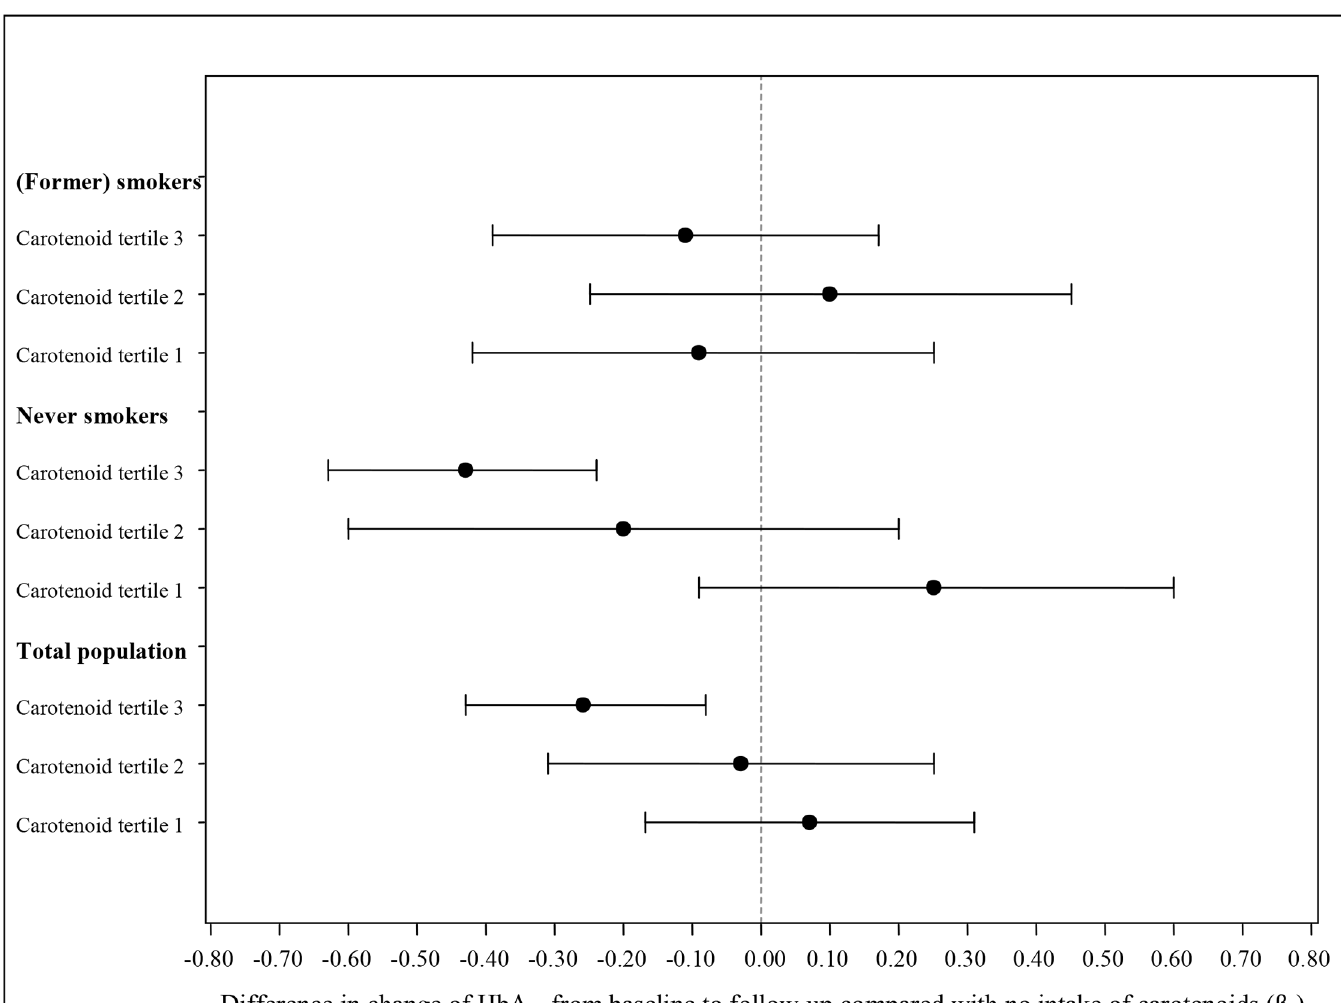
Fig 1. Longitudinal association between regular carotenoid intake amount from supplements and medications in tertiles and levels of HbA 1c over 10 years (1994/95 to 2004/05). n Total population = 4447, n never smokers = 1959, n (former) smokers = 2498; 10 people who stated they were never smokers at baseline but smokers at follow-up were partly used for both strata for the appropriate time point; HbA 1c beta estimates ( β x ) result from fully adjusted generalized estimating equation models and refer to interaction terms with time (represents the difference in change in HbA 1c levels compared with those with no intake of carotenoids, see β x in Table 3 for total population); cut-off point for tertiles 1 and 2: 1.9 mg/d; for tertiles 2 and 3: 6.8